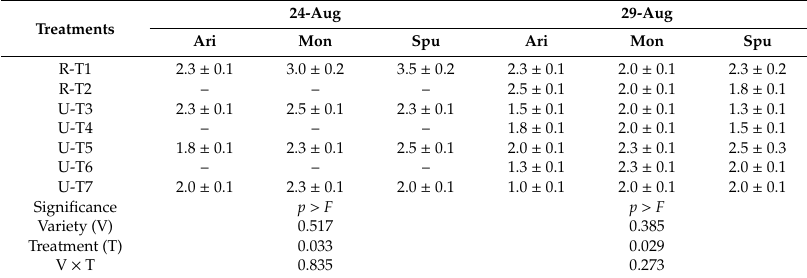
significant, likely due to the reduced exposure time (5 days) before their use. The tubers Arinda,